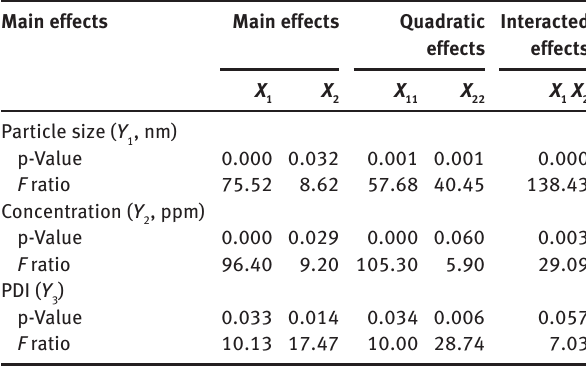
Table 3: p-Value and F ratio of the regression coefficients in the obtained